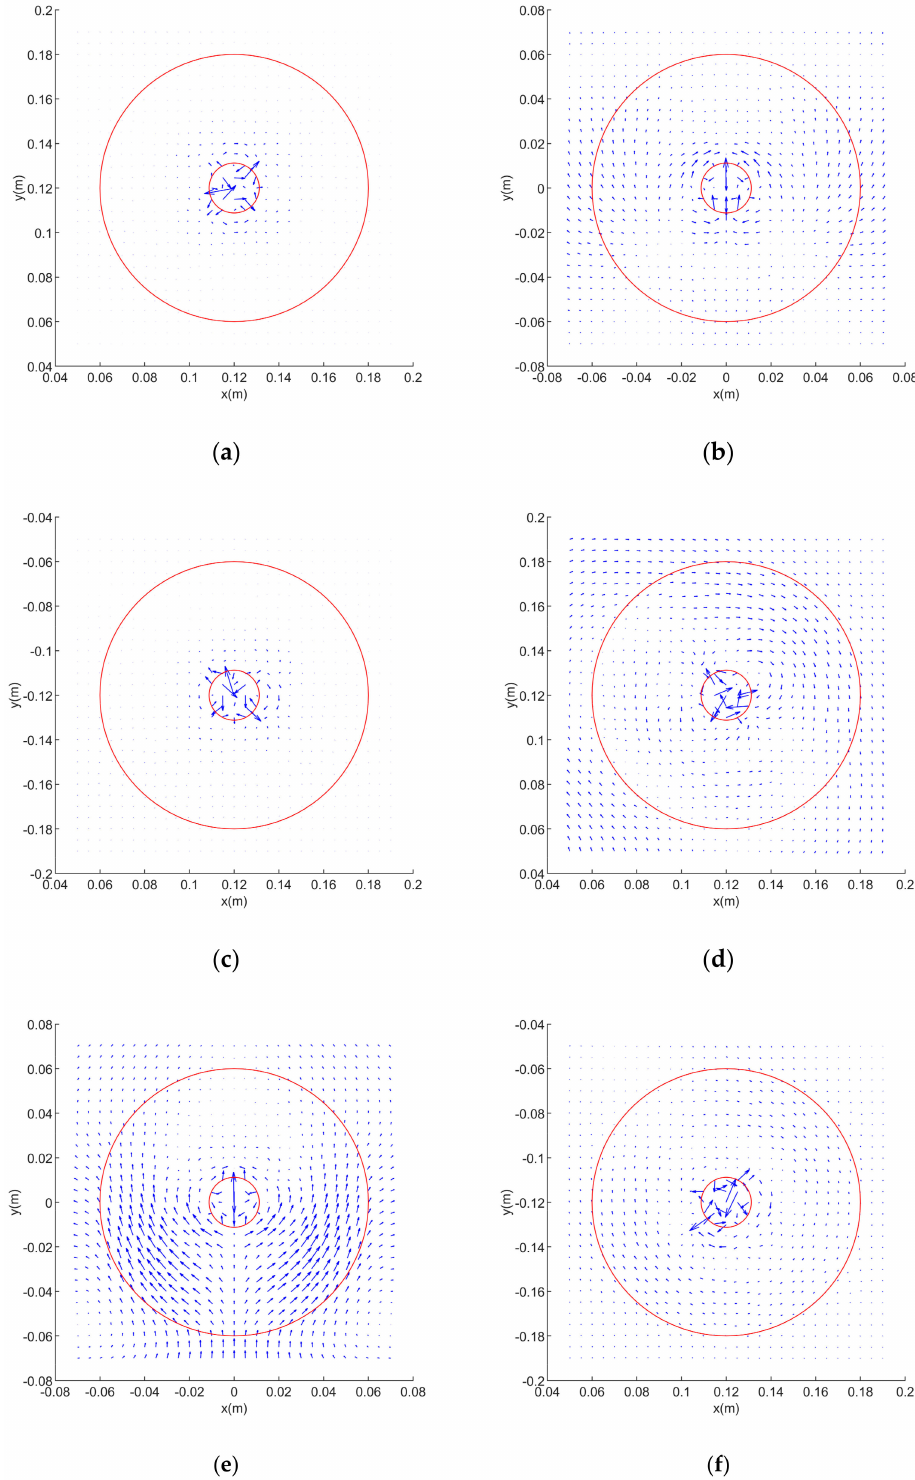
Figure A2. Power flow transmission graphs at an excitation frequency of 1050 Hz in x–y plane: ( a ) ABH(i) with BC 1, ( b ) ABH(ii) with BC 1, ( c ) ABH(iii) with BC 1, ( d ) ABH(i) with BC 2, ( e ) ABH(ii) with BC 2, ( f ) ABH(iii) with BC